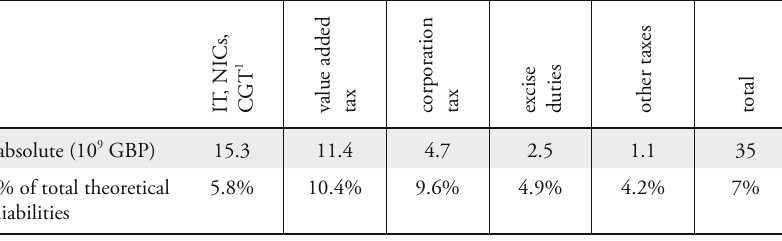
Table 5: Tax Gap by Tax Type 2011–12 in the United